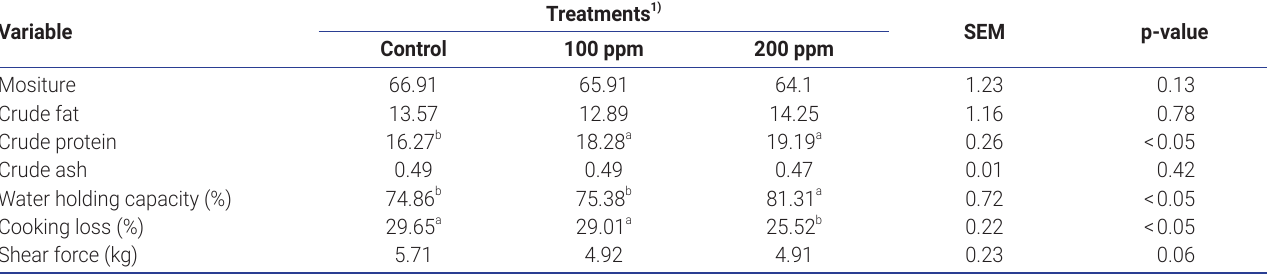
Table 3. Proximate composition (%) and physical properties of longissimus lumborum from Hanwoo steers fed with rumen protected γ-aminobu - tyric acid Variable